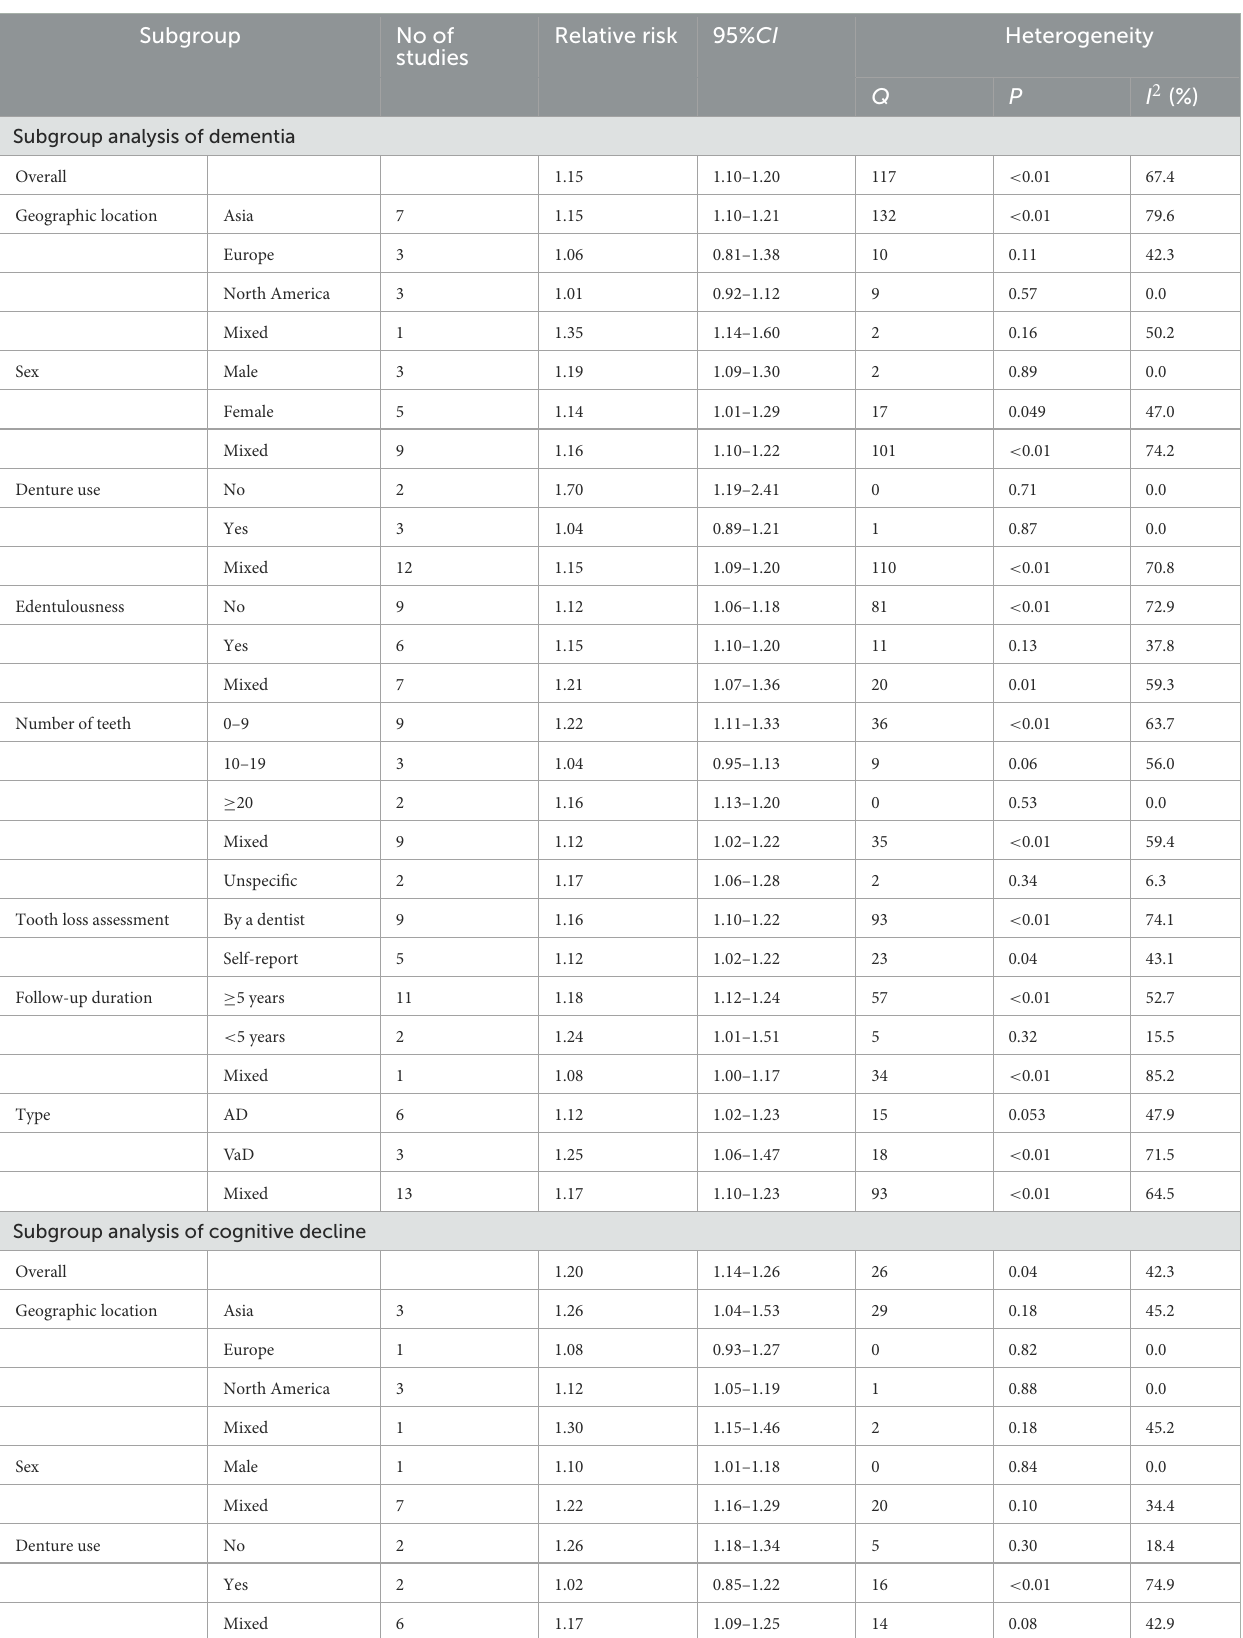
TABLE 1 Subgroup analysis of relative risks for the association between tooth loss and both dementia and cognitive decline. Subgroup No of Relative risk 95% CI Heterogeneity studies Q P I 2